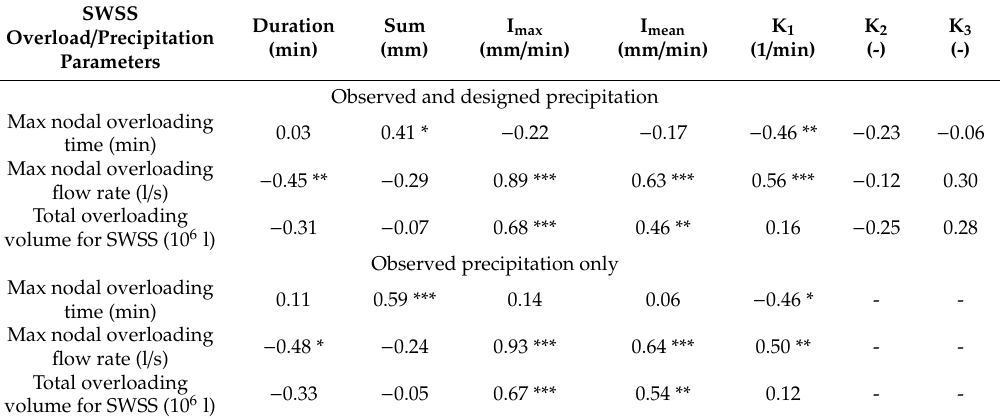
Table 7. Correlation between precipitation and SWSS-overloading